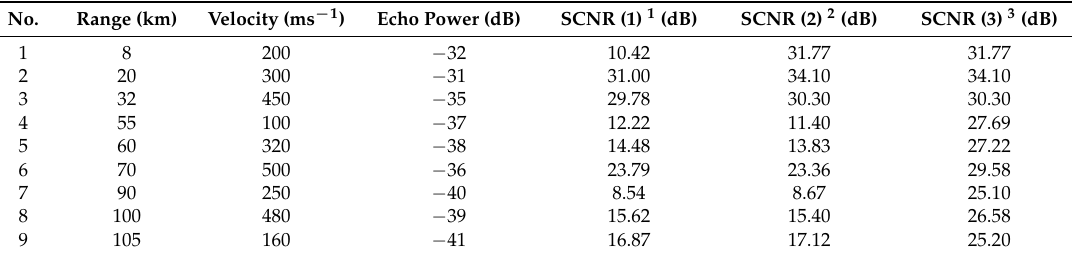
Table 2. Target parameters and